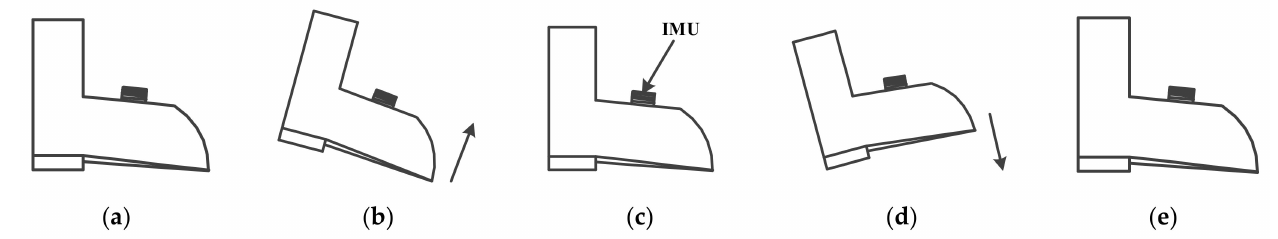
Figure 6. Decomposition diagram of foot motion: ( a ) static; ( b ) heel off the ground; ( c ) swing in the air; ( d )toe to the ground; and ( e )